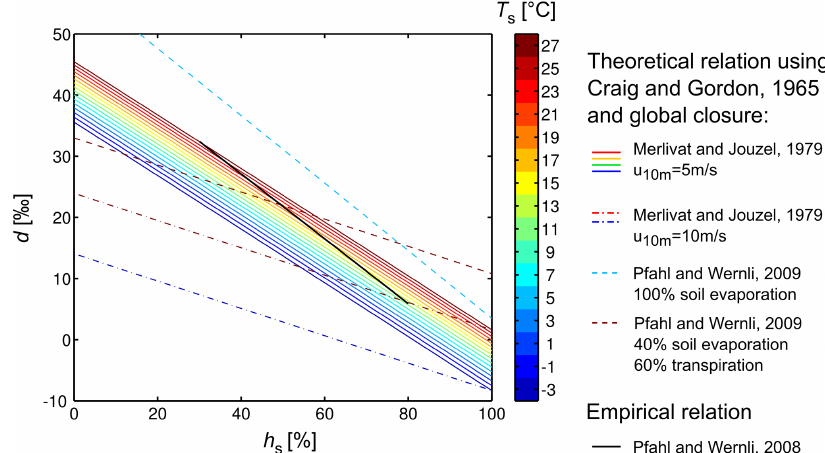
Fig. 1. The d in the evaporation flux as parameterised by the Craig–Gordon linear resistance model (Craig and Gordon, 1965) using the closure assumption from Merlivat and Jouzel (1979). Different non-equilibrium fractionation factors were used for the different lines. For the solid coloured lines the non-equilibrium fractionation factors of Merlivat and Jouzel (1979) were used with u 10m = 5ms − 1 . For the red and the blue dash-dotted line the non-equilibrium fractionation factors of Merlivat and Jouzel (1979) were used with 10m wind speeds of u 10m = 10ms − 1 . The black line shows the empirical relationship of Pfahl and Wernli (2008). The dashed red line represents the evaporation flux d from the land surface in summer assuming 40% fractionating bare soil evaporation with non-equilibrium factors of α k = 1 . 0039 for δ 2 H and α k = 1 . 0076 for δ 18 O (Pfahl and Wernli, 2009) and 60% non fractionating transpiration (e.g. Yepez et al., 2005; Lawrence et al., 2007; Sutanto et al., 2012). The soil moisture isotopic composition for the red dashed line was chosen to be δ 2 H = − 88‰, δ 18 O = − 12‰, which results in a source vapour d r s at h = 100% and 27 ◦ C of d r s = 10 . 8‰. The dashed blue line represents d of the evaporation flux from the land surface in winter assuming 100% bare soil evaporation with non-equilibrium factors of α k = 1 . 0039 for δ 2 H and α k = 1 . 0076 for δ 18 O (Pfahl and Wernli, 2009). The soil moisture isotopic composition for the blue dashed line was chosen to be δ 2 H = − 200‰, δ 18 O = − 24‰, which results in a source moisture d r s = 3 . 5‰ for T s = 5 ◦ C. The estimates for the soil moisture isotopic composition are best guesses of typical values for winter and